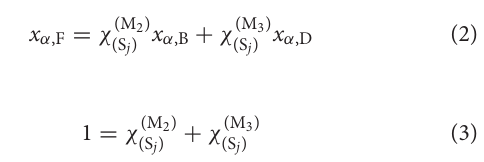
Figure 2 : (i) discretization of the thermodynamic state space, (ii) modeling of the transitions between discrete state points, and (iii) simultaneous flow optimization and heat